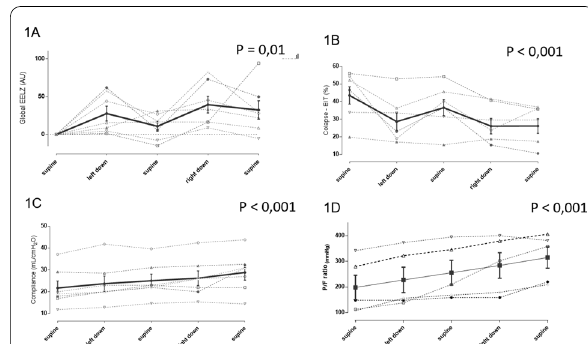
Figure 1. Changes, during sequential lateral position, global End Expiratory lung impedance (EELZ) (1A), respiratory compliance (1C) and mass of collapsed lung (%) estimated by EIT (1B), in PaO2/FIO2 ratio (1D). A significant improvement in PaO2/FIO2 ratio,